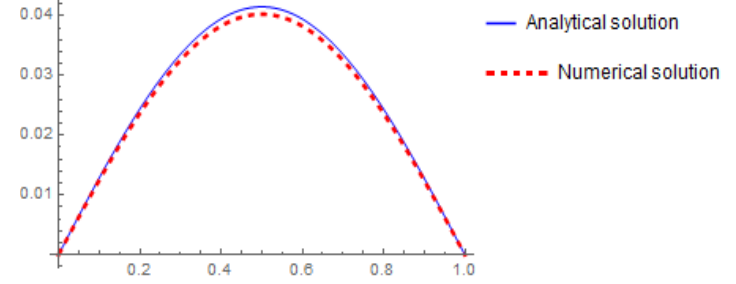
Figure 1. The comparison of the analytical solution with the numerical solution obtained by LHPM for α = 1.47, t =